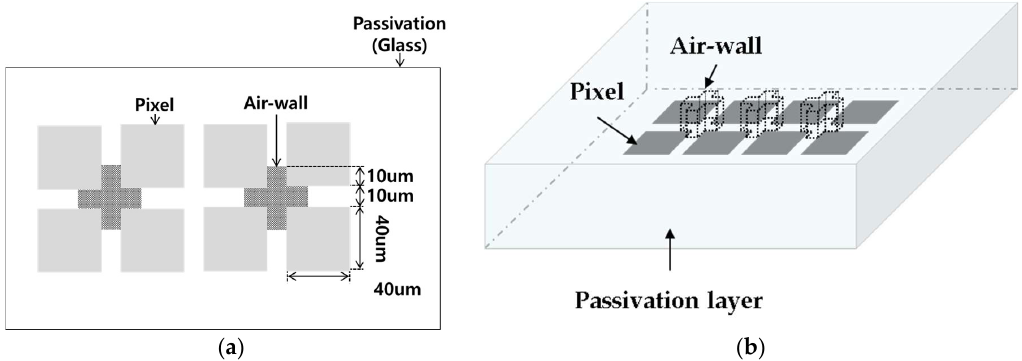
Figure 6. Modeling of the air-walls in the passivation layer: ( a ) top-view; ( b ) three-dimensional view. In the simulation, the performance was characterized in terms of Δ C avg and Δ C norm , which is the average Δ C avg normalized by the average ridge capacitance as shown in Equation (2). Δ C avg is the difference between the averaged capacitance of pixels underneath a ridge, C average of ridges , and that of pixels underneath a valley, C average of valleys .